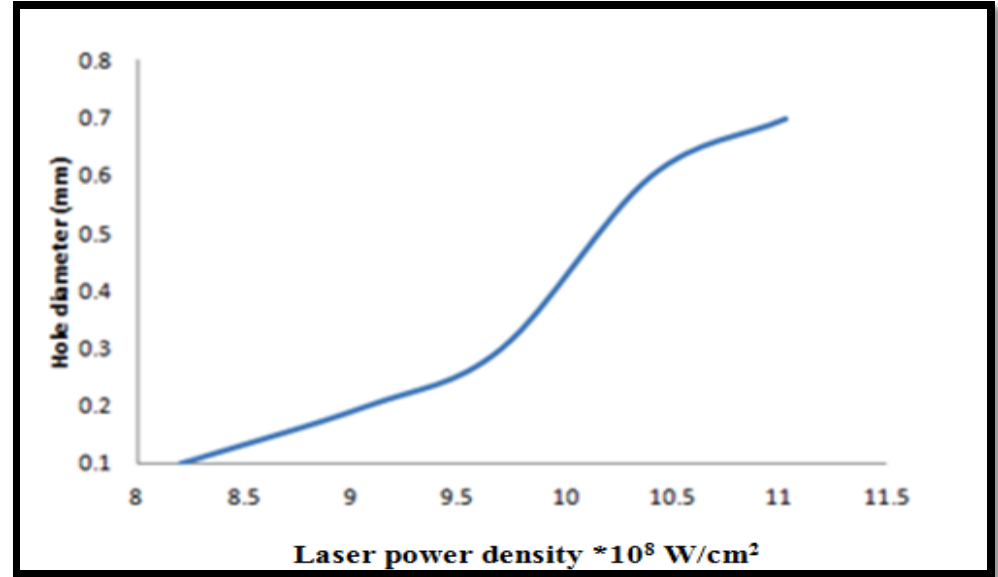
Fig.5: Laser power density versus drilled diameter in aluminum.